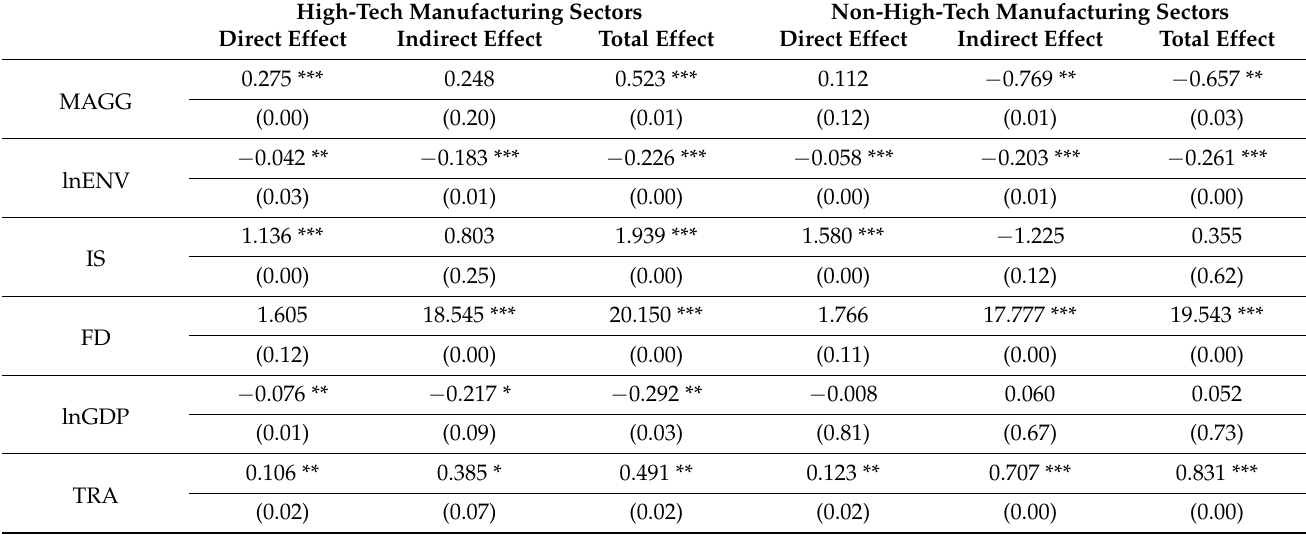
Table 11. Decomposition results of the spatial effects of high-tech and non-high-tech manufacturing